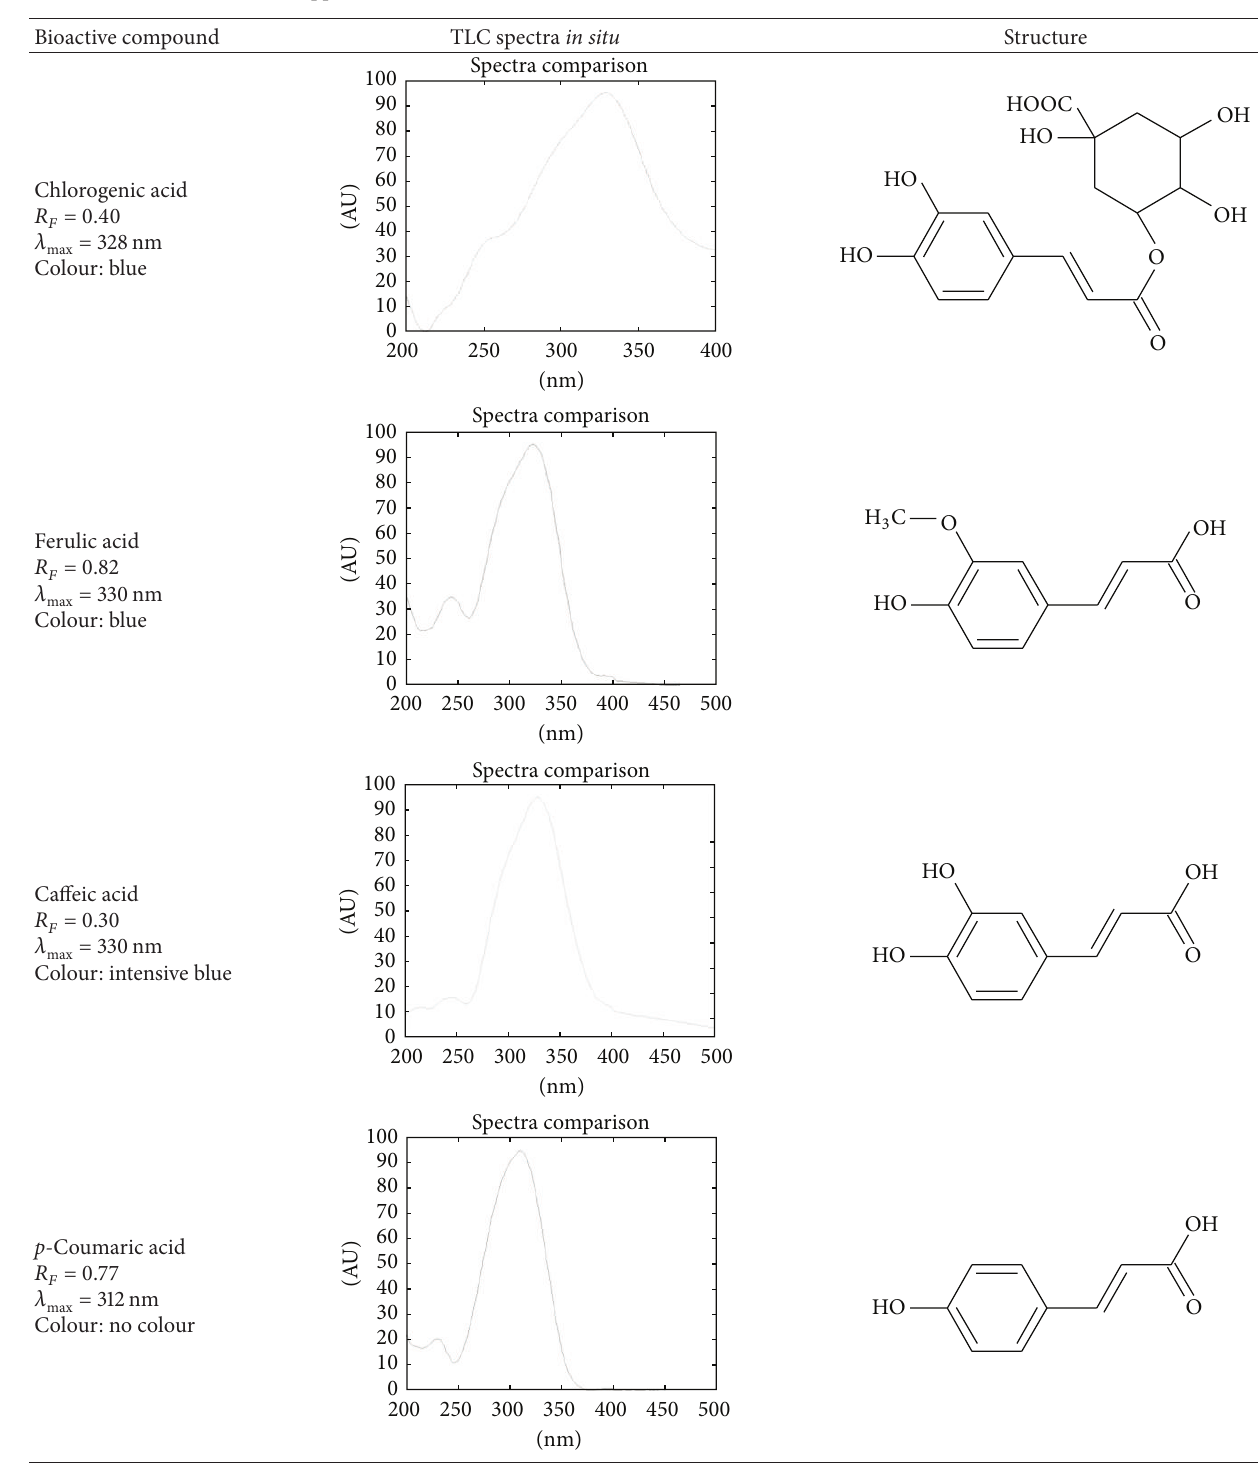
Table 1: Identification parameters of polyphenolics and xanthines: retention factor, color of band under 366nm, and spectra after spraying with aluminium chloride (not applicable for caffeine and